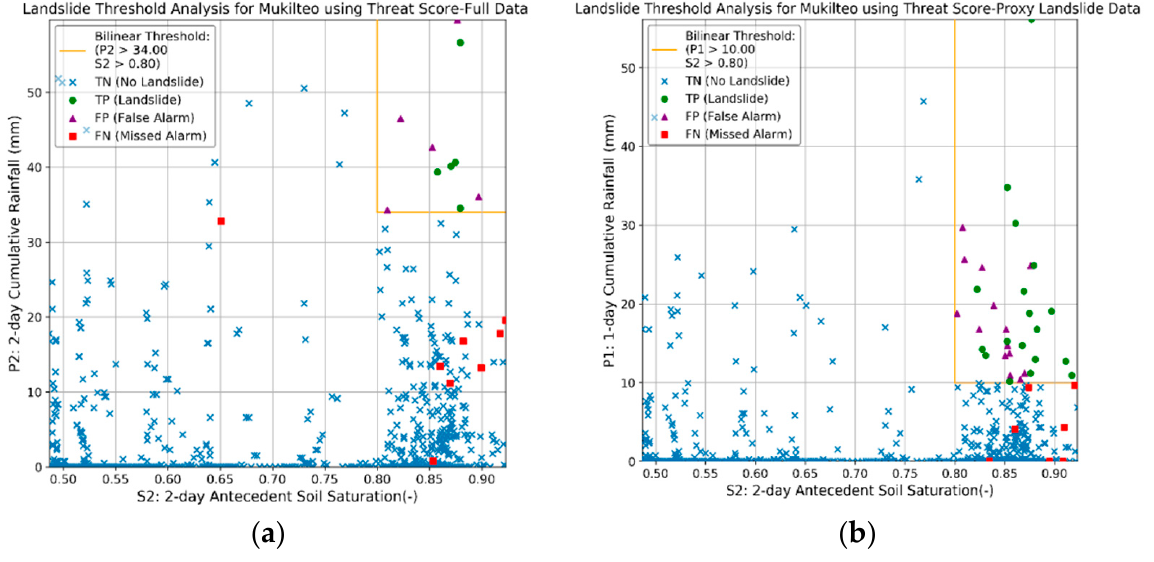
Figure 11. Two HydroMet output plots showing a comparison of using observed landslide timing versus positive pore-water pressure as a proxy for landslide occurrence. Threat score was the statistic used for optimization and both analyses tested a range of 1–2 days precipitation and 1–2 days of saturation to give four daily threshold options to optimize. ( a ) Using actual timing of landslide occurrence, a daily threshold of P2:S2 is optimal with a threshold of P2 > 32 mm and S2 > 0.8. ( b ) When positive pore water pressures are a proxy for landslide occurrence, the optimal threshold is P1:S2 with P1 > 10 mm and S2 >